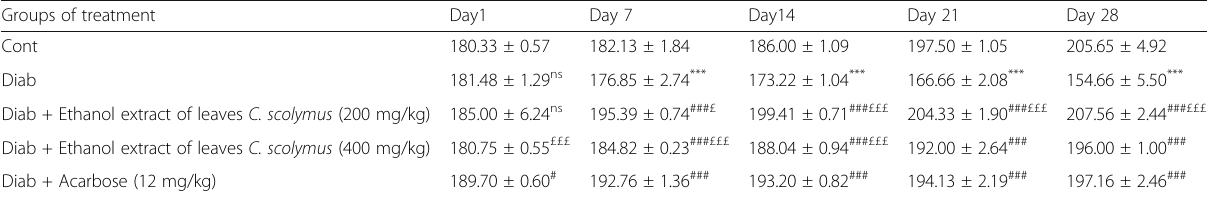
Diabetic rats were orally administered with the ethanol extract from leaves of C. scolymus and acarbose at the doses mentioned earlier for 28 days. Values are given as means ± SD ( n = 8). *** p ≤ 0.001 were considered significant compared to control group; # p ≤ 0.05, ### p ≤ 0.001 were considered